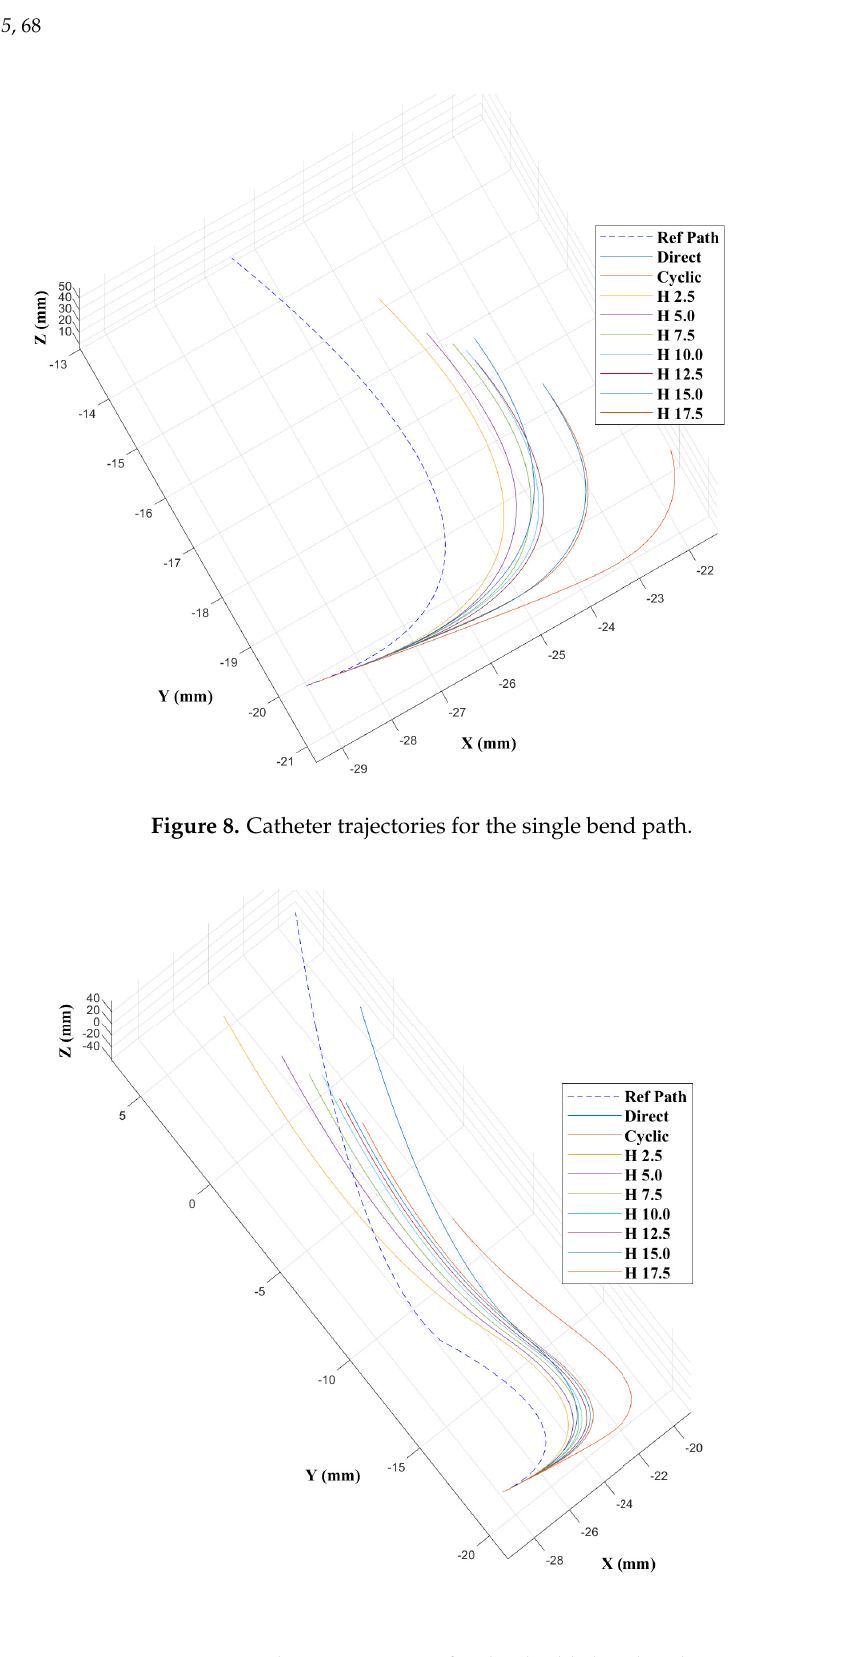
Figure 9. Catheter trajectories for the double bend